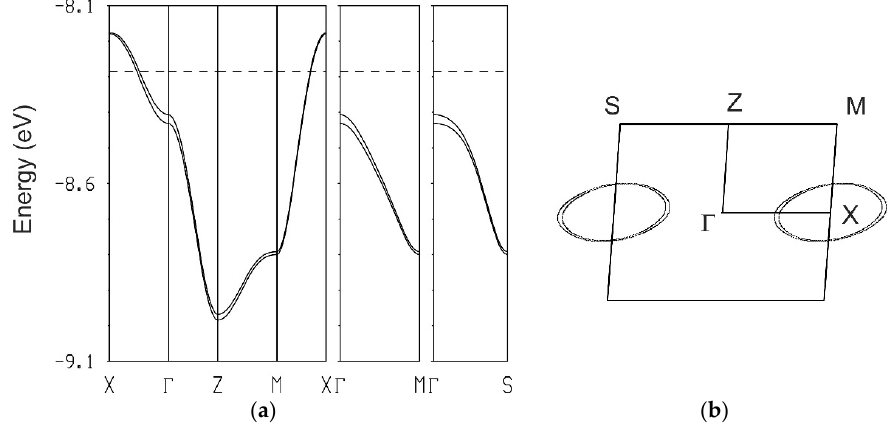
Figure 4. Calculated band structure ( a ) and Fermi surface ( b ) for β ”-(CNB-EDT-TTF) 4 BF 4 where Г = (0, 0), X = (a*/2, 0), Z = (0, c*/2), M = (a*/2, c*/2) and S = ( − a*/2, c*/2). The dashed line in ( a ) refers to the Fermi level.